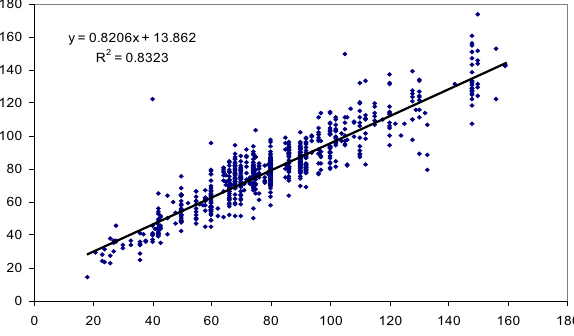
Fig. 8 Actual versus predicted choke size for FL model training (Radii = 0.1)